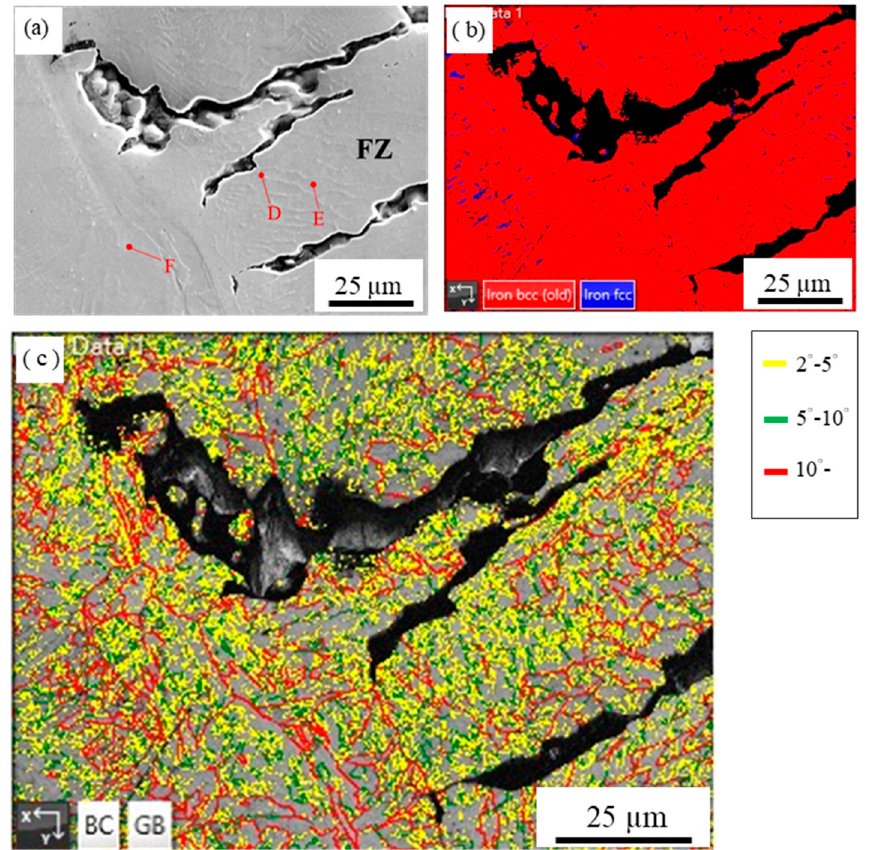
Figure 7. Selected area in Figure 6a at higher magnification: ( a ) EPMA SEI, ( b ) EBSD crystallo- graphic map, ( c ) EBSD boundary misorientation map. map, ( c ) EBSD boundary misorientation